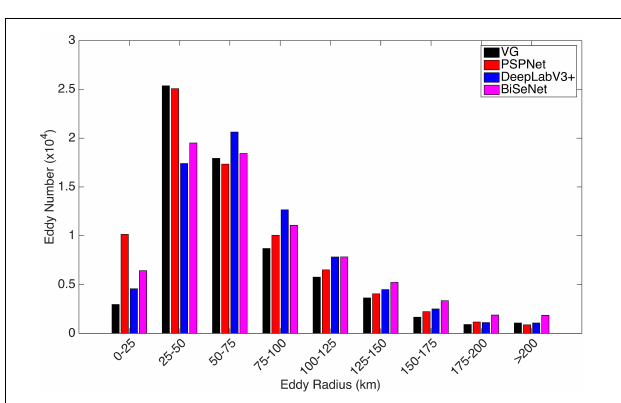
FIGURE 5 | Time series of the daily number of eddies identified by the VG and three AI algorithms in the STCC region during 2015. Black, red, blue, and purple curves represent the results from VG, PSPNet, DeepLabV3+, and BiSeNer algorithm, respectively. “Error” is the difference between the three AI-based results and the VG results, “re-error” is the relative error which is defined as the error divided by the VG results, and “corr” is the correlation coefficient between the results from the three AI-based algorithms and the VG algorithm.